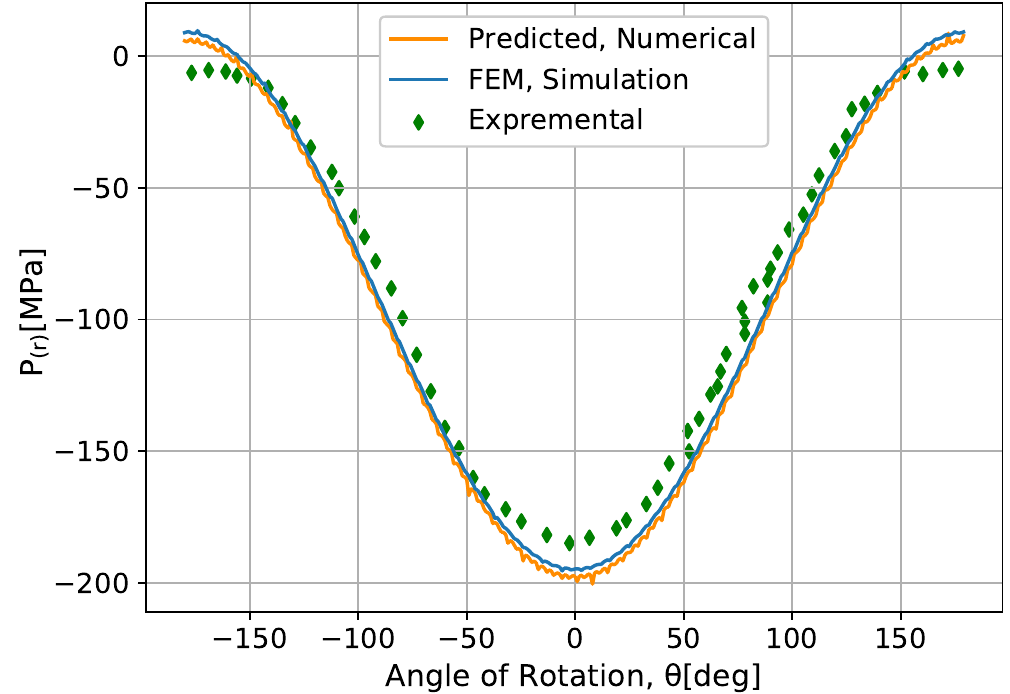
Figure 14. Radial stress distribution in rolling die under rolling gap for given number of cyclic loads ( n = 1 10 3 ×